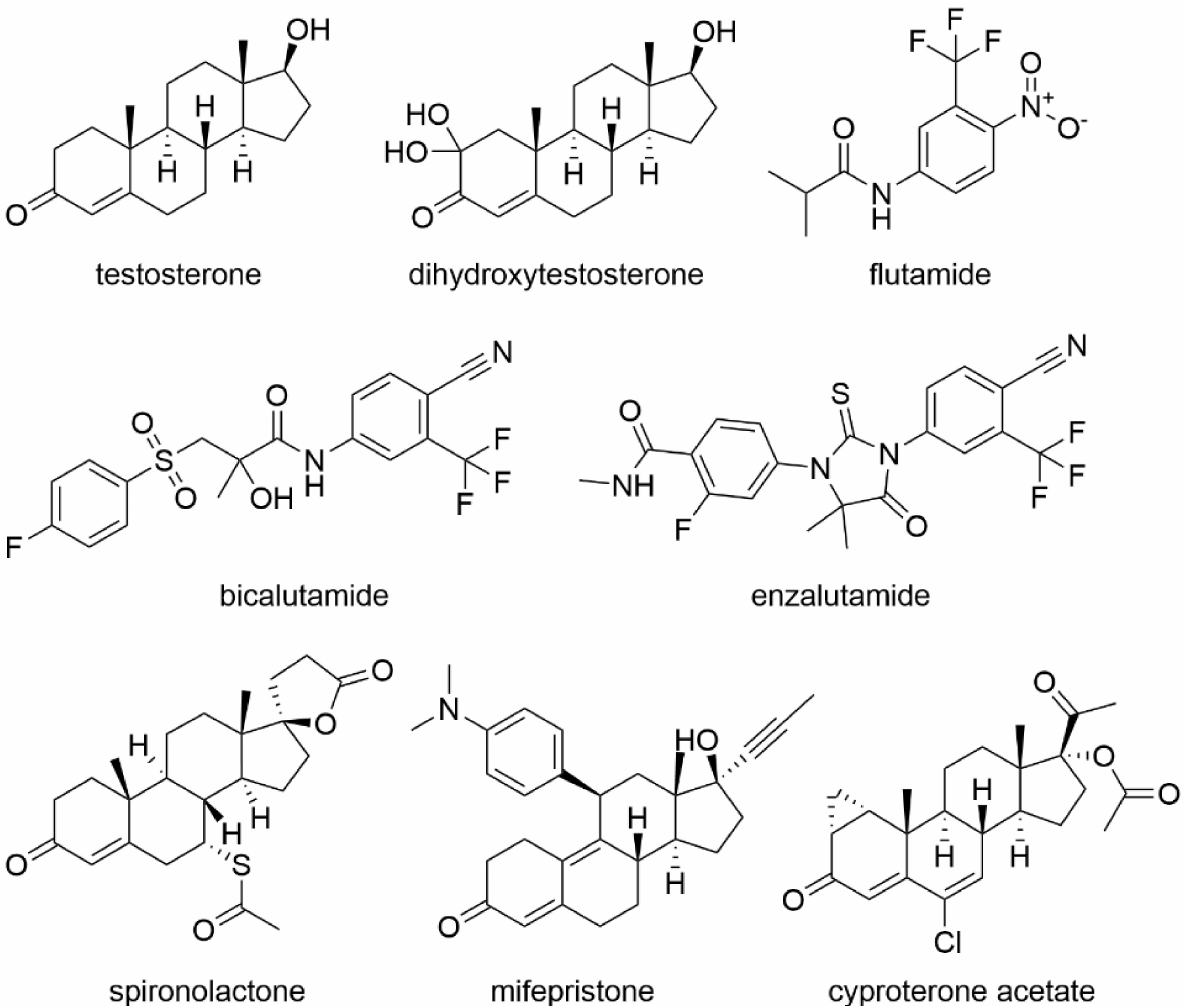
Figure 1. Chemical structures of antiandrogens used in prostate cancer